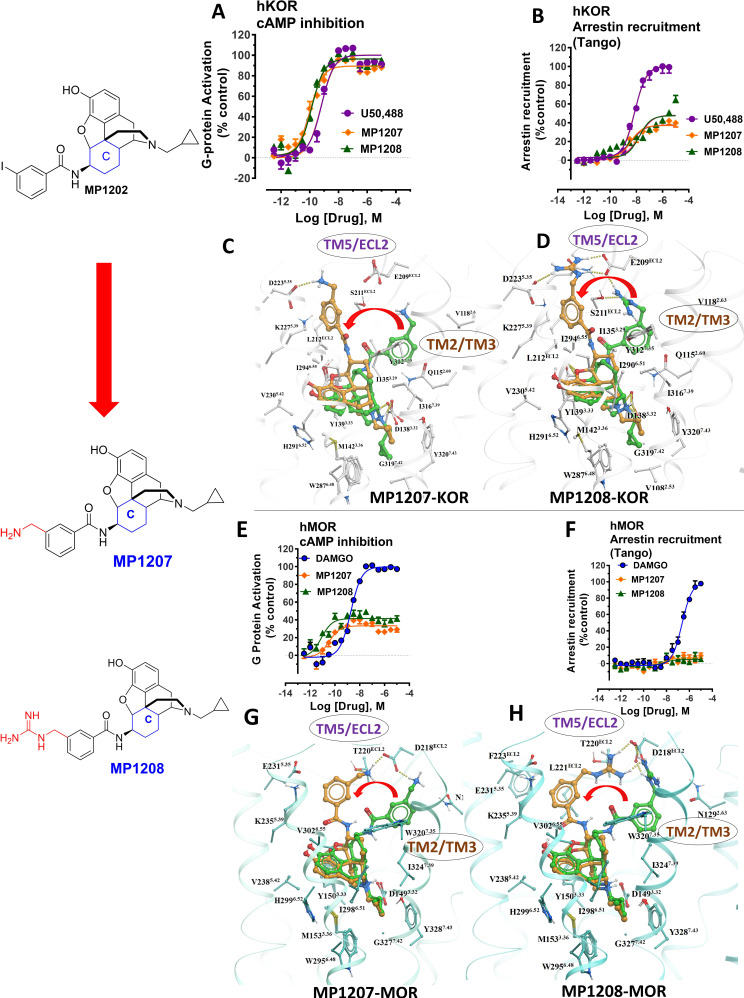
meta-Amino (MP1207) and meta-guanidino (MP1208) analogs prefer the chair conformation and target the TM5-ECL2 region and are G protein biased agonists at KOR and at MOR show no measurable arrestin recruitment.(A-B) MP1207 (orange) and MP1208 (green) are full agonists at hKOR in cAMP inhibition (N = 3) and partial agonists in Tango-arrestin recruitment assays (N = 3) compared to U50, 488 (purple). (C–D) Docking results showed that amino methyl (MP1207) or guanidino (MP1208) moieties (replacing the iodo group in MP1202) forced these compounds in chair form preferred confirmation at hKOR (chair form in brown stick and boat form in green stick). Unlike boat MP1202, chair MP1207 at hKOR may form a new salt bridge interaction between amino group and D2235.35 and E209ECL2 pulling amidophenyl moiety away from the hydrophobic pocket between TM2 and TM3 (C). Likewise, chair MP1208 forms salt bridge interactions between guanidino group and D2235.35 as well as with E209ECL2 (D) The flip in conformation of ringC from boat to chair for both MP1207 and MP1208 is shown by a red arrow. (E–F) MP1207 (orange) and MP1208 (green) are partial agonists at hMOR in cAMP inhibition (N = 3). No arrestin recruitment was observed for both agonists in Tango-arrestin recruitment assays (N = 3) compared to DAMGO (blue). (G–H) At hMOR chair forms of MP1207 and MP1208 introduce additional interactions between amino or guanidino group and D218ECL2 and T220ECL2. Thus, biased signaling events of MP1207 and MP1208 are dictated from chair favored binding via the involvement of their m-amino or m-guanidino group with TM5 -ECL2 region. See Appendix 1—table 7 for values, Appendix 1—figure 4 and Appendix 1—table 10 for bias calculations.